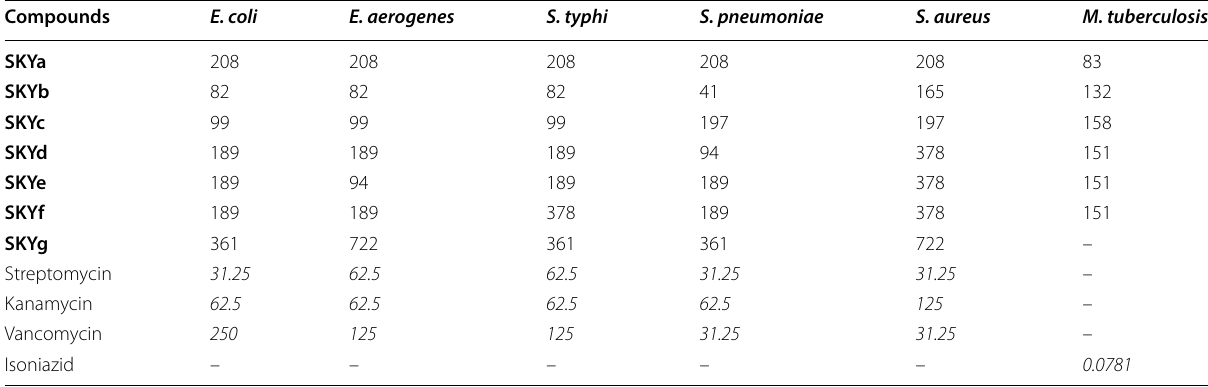
Results are mean of triplicate values (n Italic values indicate standard